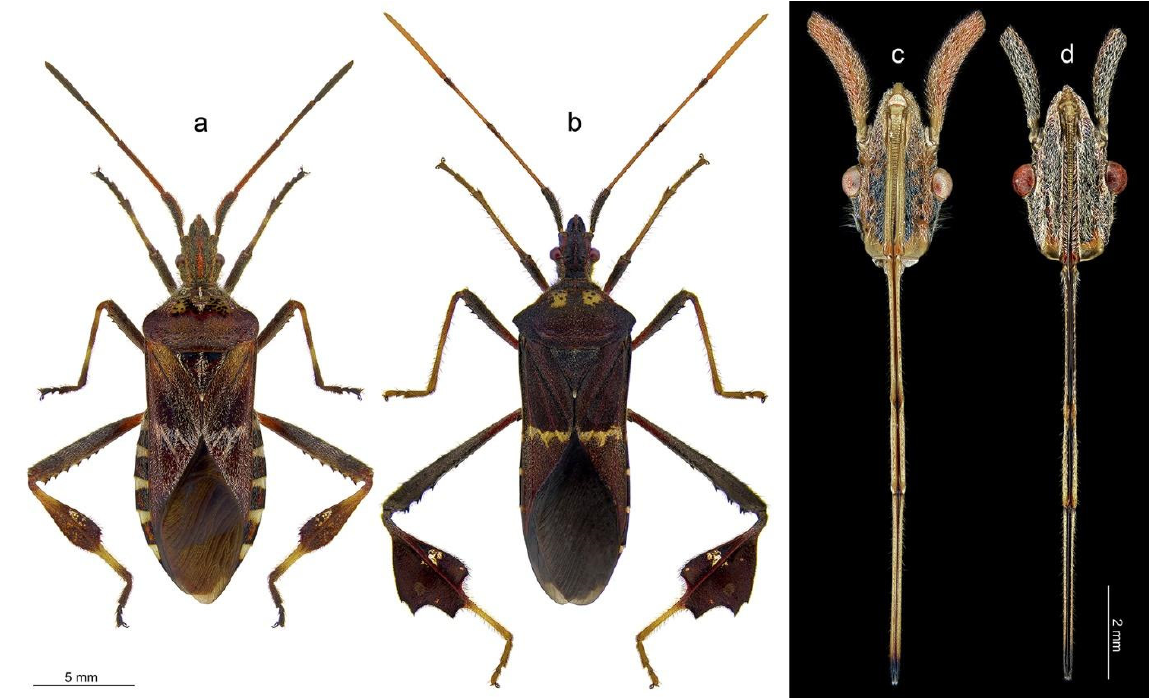
Figure 1. Dorsal habitus of examined species ( a , b ) and morphology of head with labium ( c , d ); Leptoglossus occidentalis ( a , c ), Leptoglossus zonatus ( b , d ).